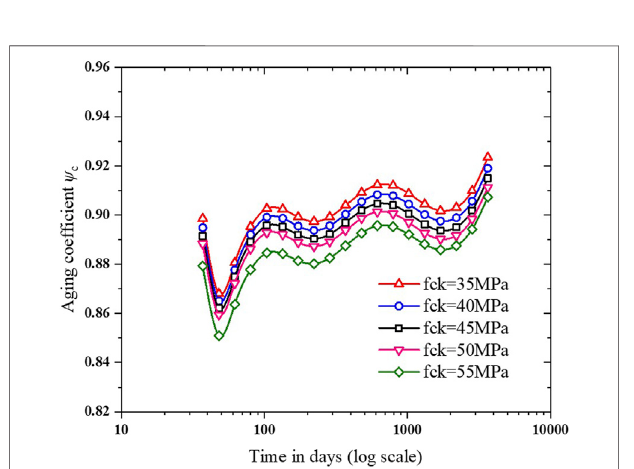
FIGURE 10 | Aging coef fi cient with increasing concrete